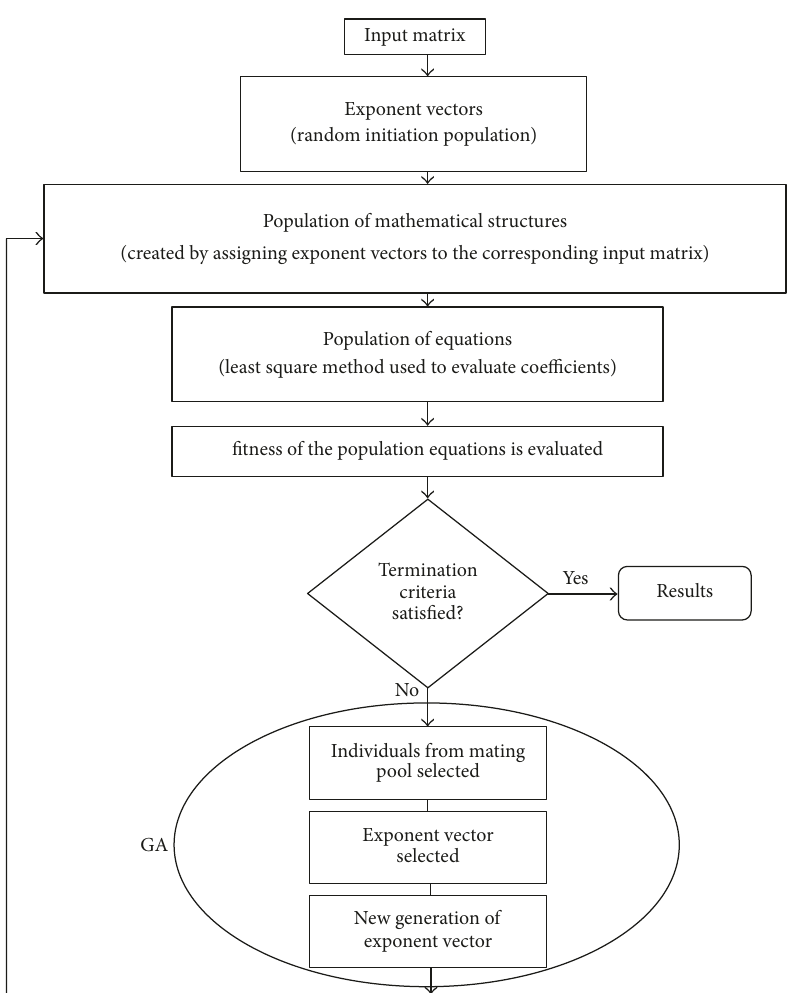
Figure 17: Typical flow diagram for EPR procedure